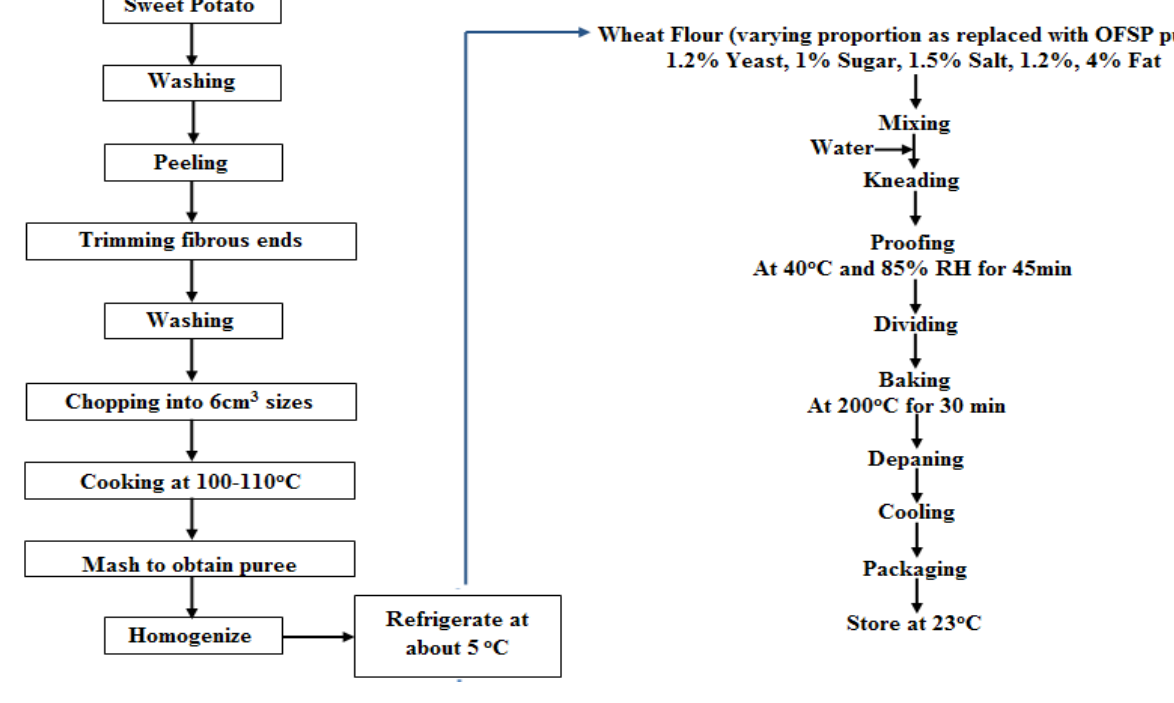
Figure 1: Flow diagram for baking of OFSP